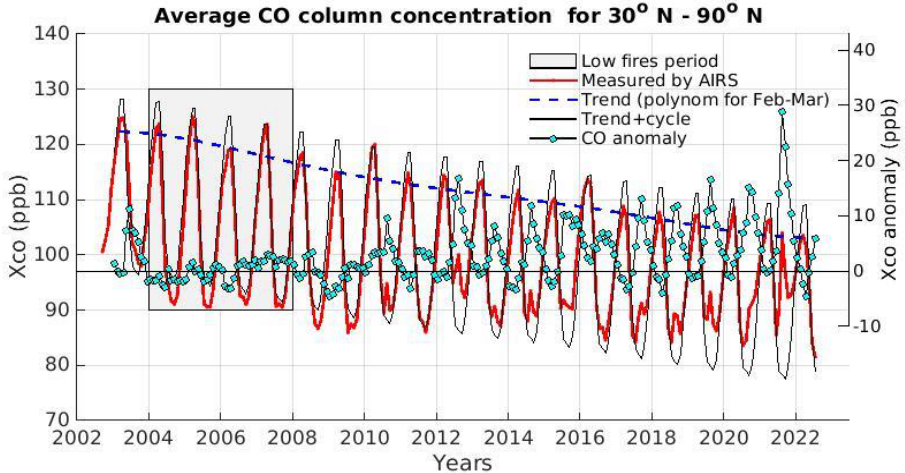
Figure 3. Original data, trend, seasonal cycle + trend (left scale), and fire-induced CO anomaly (right scale). Units are vertically averaged VMR in ppb.